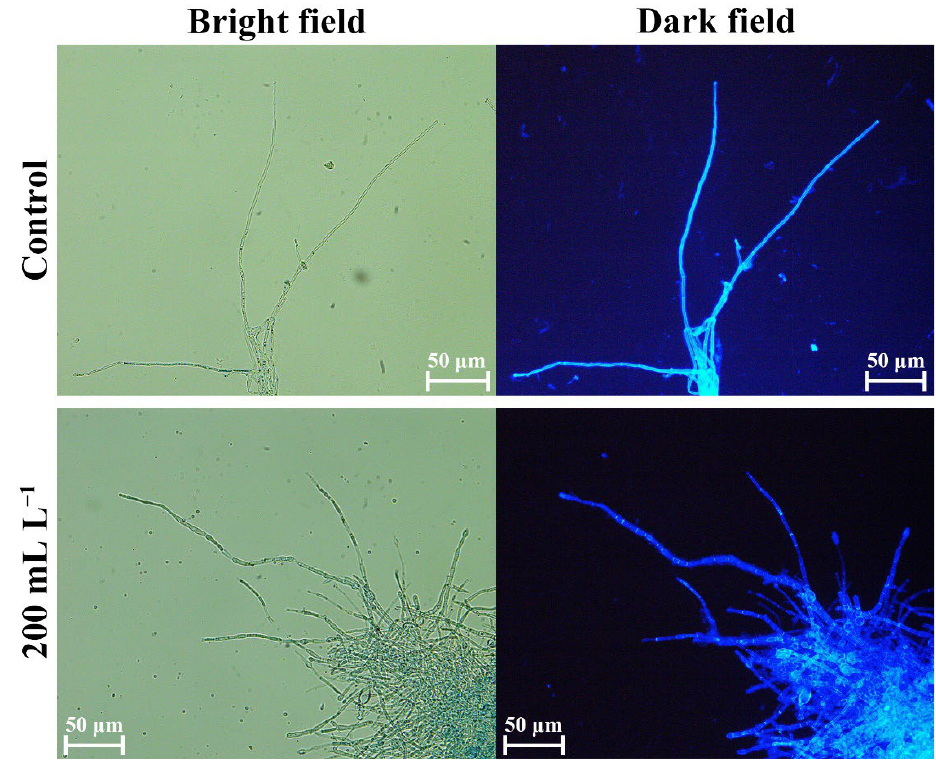
Figure 5. The effect of SS on D. glomerata cell wall observed with calcofluor white staining.